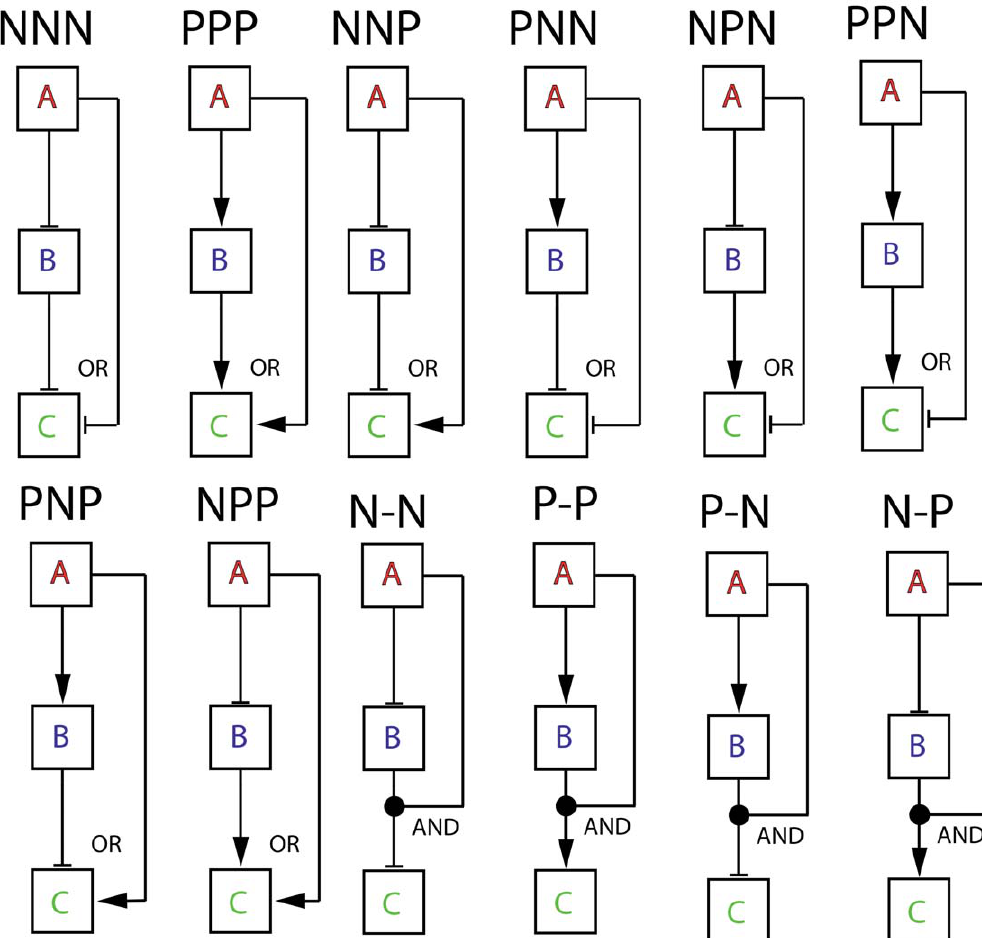
Figure 1. Various types of feedforward loops (FFLs) considerd . FFLs consist of three genes which code for three different transcription factors A, B and C where B regulates C and A regulates both B and C. There are three regulatory connections in FFLs. Since each of these regulatory connections can be either positive or negative, totally there are eight different FFLs. We use three letter codes as ‘‘FGH’’ where ‘F’ denotes the type of regulation of B by A and ‘G’ denotes the type of regulation of C by B and ‘H’ denotes the type of regulation of C by A. Here PPP, NPN, PNN and NNP (termed as C1, C2, C3 and C4) are coherent type and PNP, NNN, PPN and NPP (termed as I1, I2, I3 and I4) are incoherent type. When dimer of A and B regulate C through AND-logic, there are four possible FFLs as P-P, P-N, N-N and